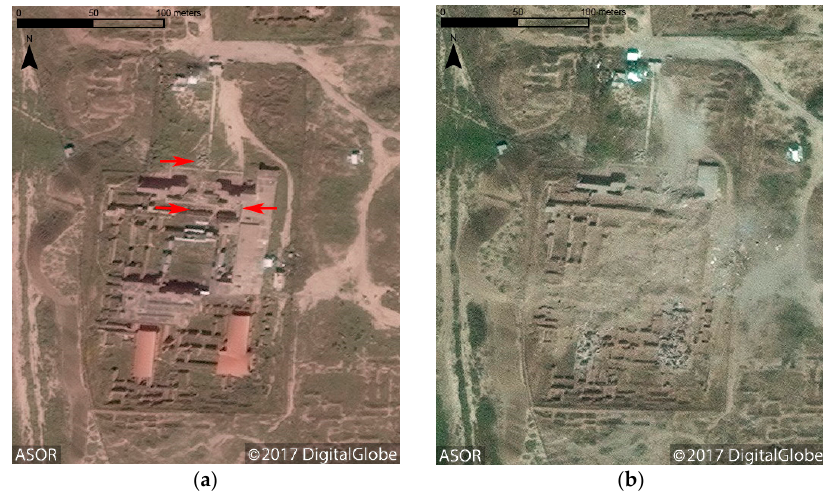
Figure 5. Further destruction at the Northwest Palace of Nimrud ( a ) with more vehicle tracks and removal of stone reliefs noted with the red arrows (DigitalGlobe NextView License; 1 April 2015); ( b ) after the detonation of bombs by ISIS within the palace walls (DigitalGlobe NextView License; 17 April 2015).